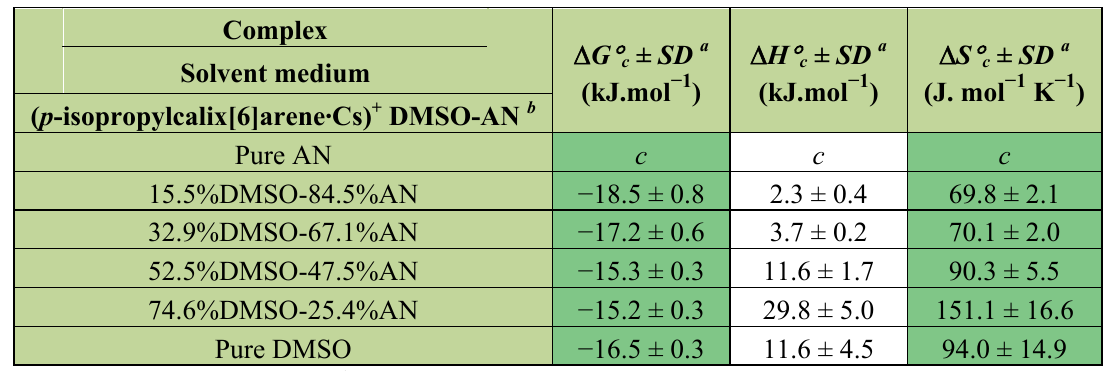
) of ( p -isopropylcalix[6]arene·Cs) + f